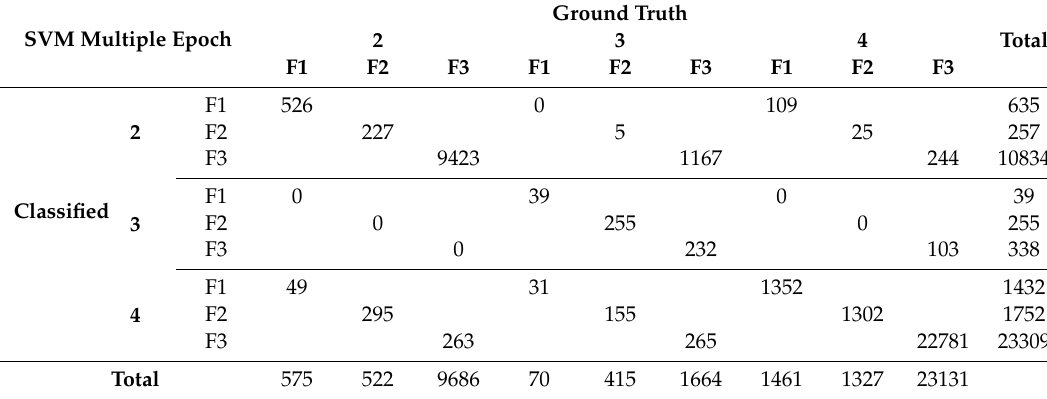
Table A5. Confusion matrix of multitemporal classification performed with the Support Vector Machine (SVM) classifier. F1 - farm 1, F2 - farm 2 and F3 - farm 3.